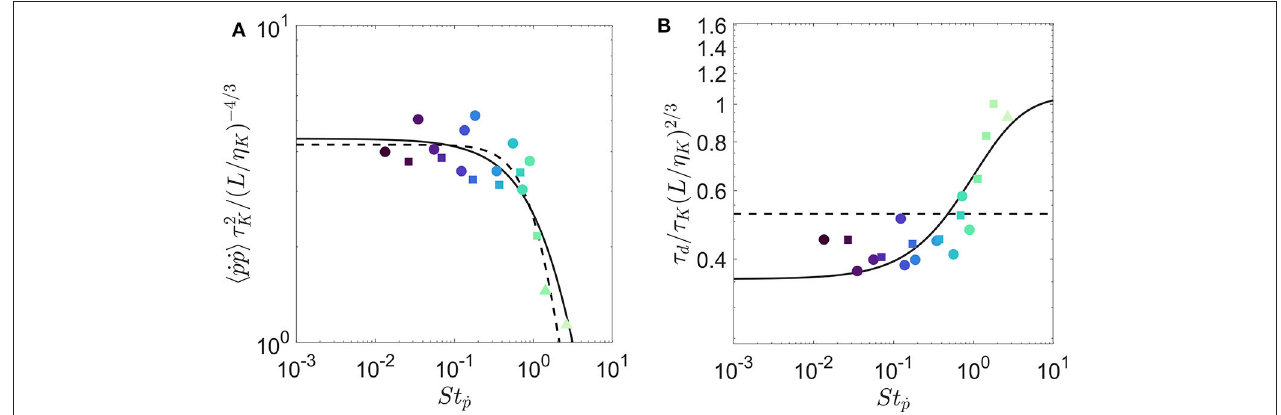
FIGURE 4 | Evolution of transfer functions of (A) variance of tumbling rate and (B) correlation time-scale of rotation with respect to rotational Stokes number for fibers of various length and